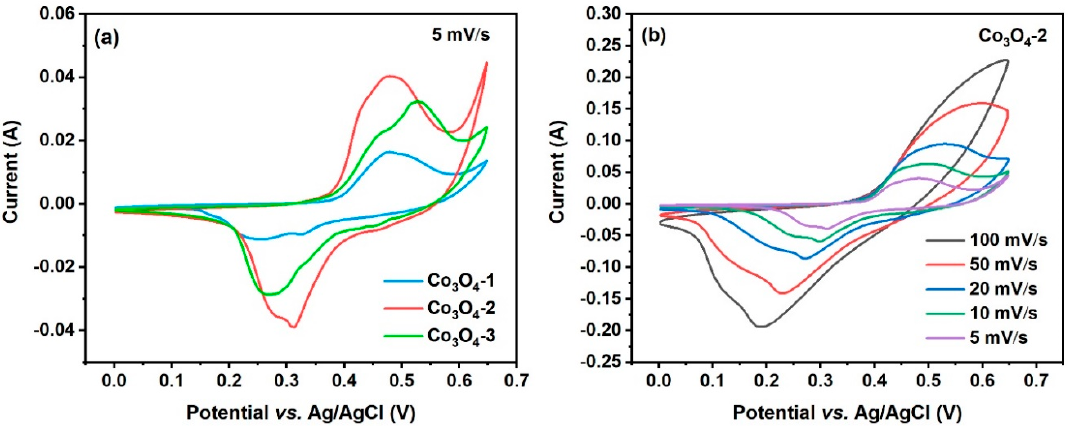
Figure 3. ( a ) Cyclic voltammetry (CV) curves of Co 3 O 4 -1, Co 3 O 4 -2 and Co 3 O 4 -3 electrodes at scan rate of 5 mV / s; ( b ) CV curves of Co 3 O 4 -2 electrode at typical scan rates ranging from 5 to 100 mV / s.